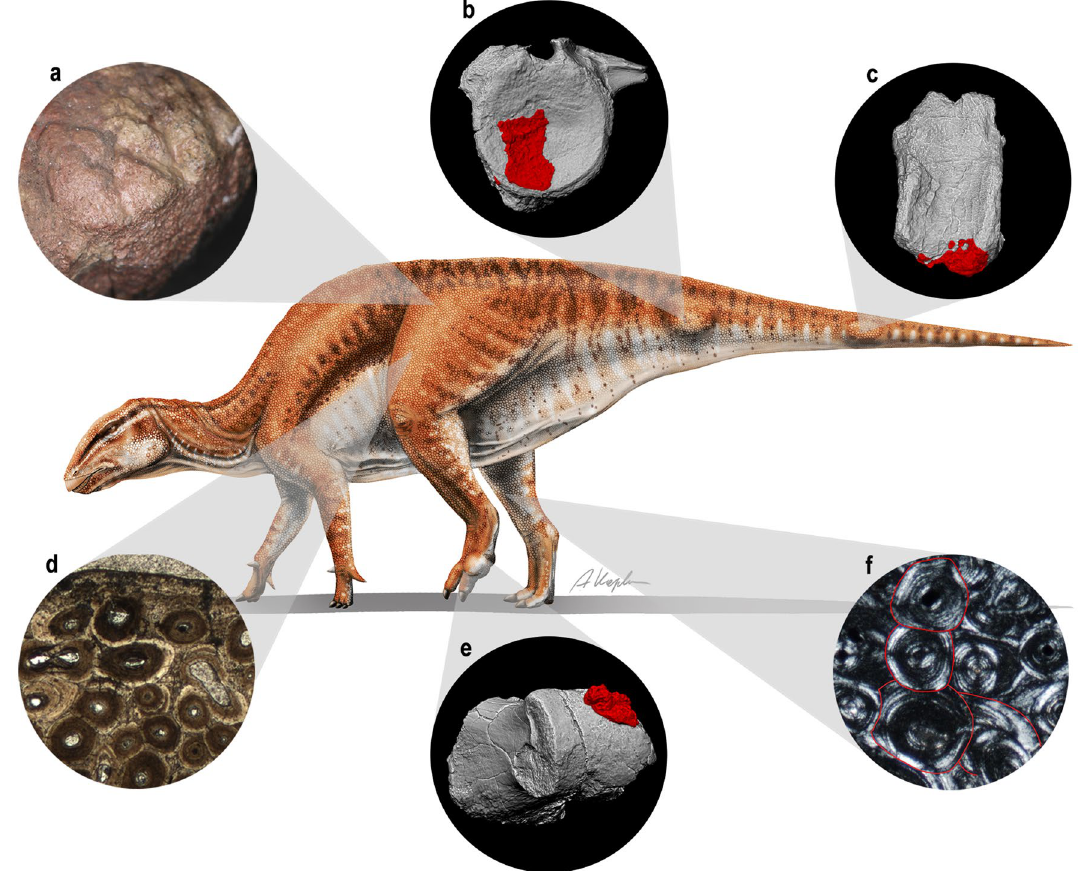
Figure 5. Life reconstruction of Gobihadros mongoliensis ZPAL MgD-III/3 with highlighted features indicating its senescent age. ( a ) Closed transcortical channels on th e proximal articular surface of the femur. ( b ) Calcium deposits on the distal surface of the proximal caudal vertebra. ( c ) Calcium deposits on the ventral surface of the middle caudal vertebra. ( d ) The presence of the EFS and extensive secondary remodeling in the external cortex of the femur. ( e ) Calcium deposits on the distal articular surface of the first phalanx of digit IV. ( f ) Four generations of secondary osteons in the middle cortex of the tibia. The reconstruction of G. mongoliensis drawn by A.